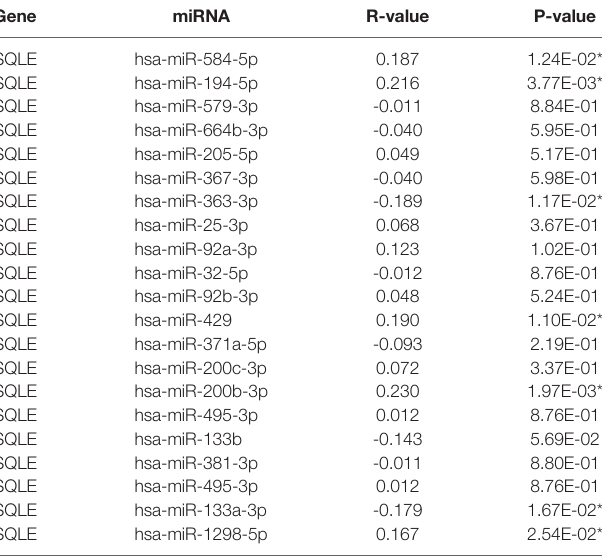
TABLE 1 | The expression correlation between predicted miRNAs and SQLE in PAAD analyzed by starBase database. Gene